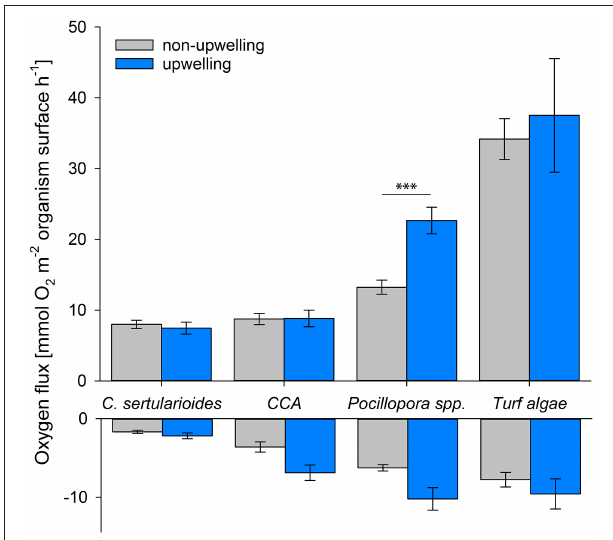
FIGURE 3 | Organism-specific oxygen fluxes. Net primary production (positive) and respiration rates (negative) of the dominant primary producers (in mmol O 2 flux normalized to organism surface area) under non-upwelling (May 2013–January 2014) and upwelling conditions (February–April 2014). *** p < 0.001